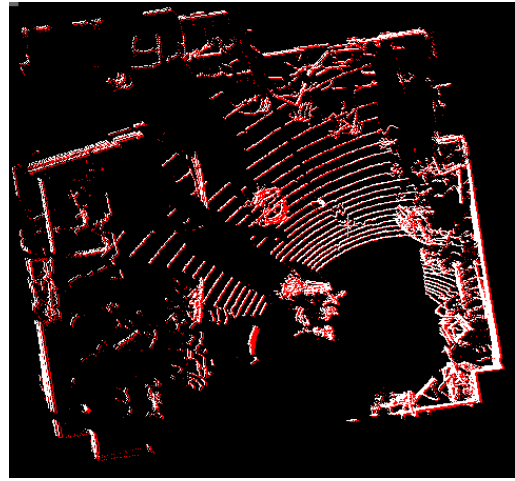
Figure 7. Comparison of output of the proposed (white) and ICP algorithms (red)